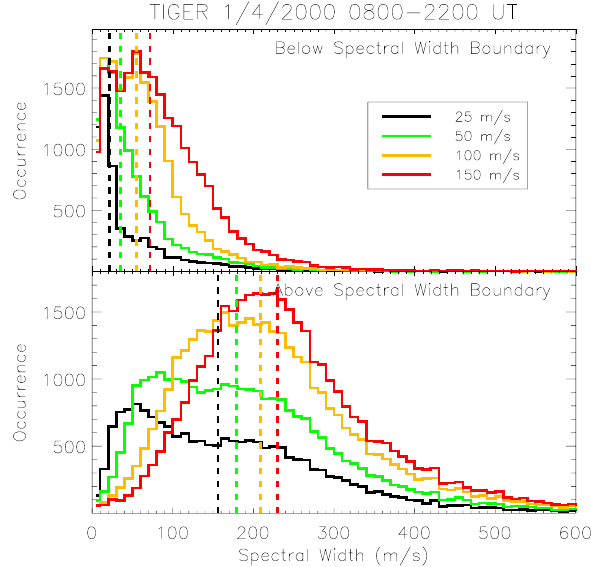
Fig. 5. Spectral width distributions for echoes measured on TIGER beam 4 during 08:00 to 22:00 UT, 1 April 2000. The distribu- tions below (top panel) and above (bottom panel) the spectral width boundary (SWB) were identified using spectral width thresholds of 25ms − 1 (black), 50ms − 1 (green), 100ms − 1 (orange), and 150ms − 1 (red). The corresponding vertical chains indicate the me- dian values of the